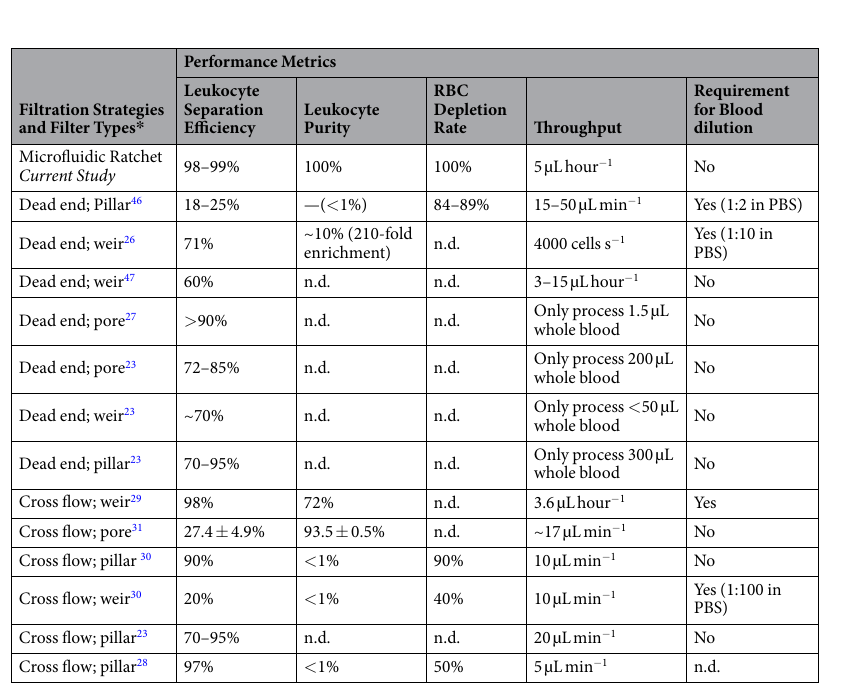
Figure 7. Distribution of monocytes sorted from whole blood from the same donor in three trials. Inset graphs show the composition of leukocytes subsets in O8 and 9.